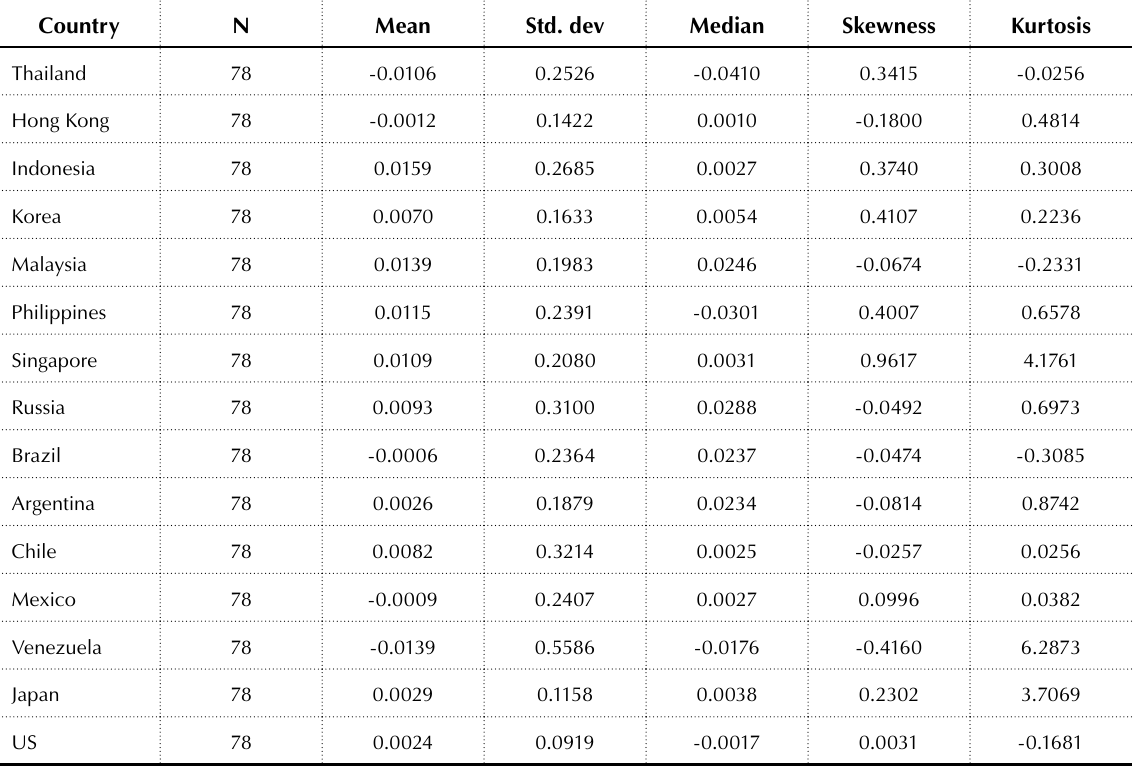
Table 1. Summary